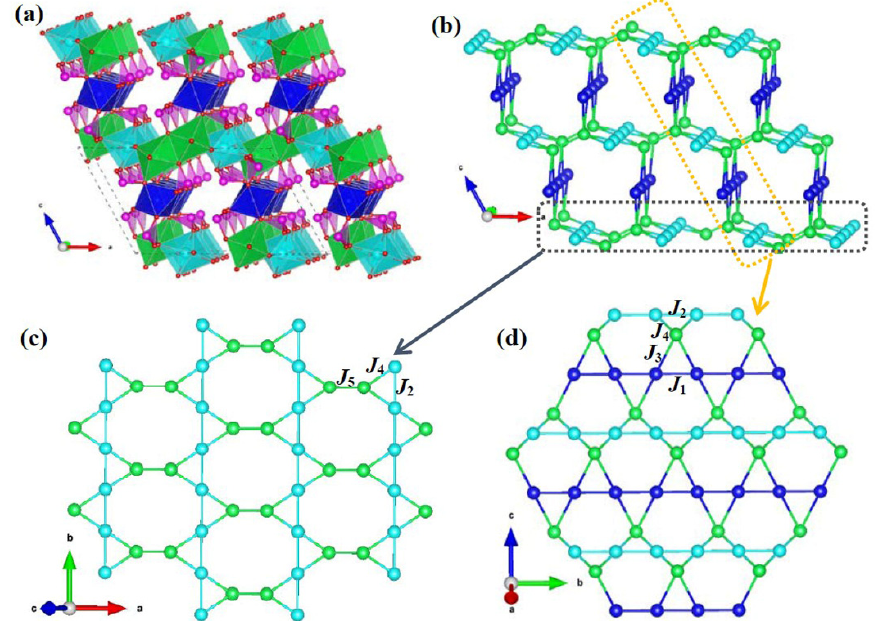
Figure 2. ( a ) The three-dimensional structure frameworks and ( b ) topological spin structures of Mn 3 O(SeO 3 ) 3 ; ( c ) and ( d ) show the octa-kagomé and staircase-kagomé spin sublattices, respectively. Here the blue, green, light blue and pink polyhedra represent Mn1O 6 , Mn2O 6 , Mn3O 6 and SeO 3 , respectively. Balls of the above colors represent Mn1, Mn2 and Mn3 ions, respectively.